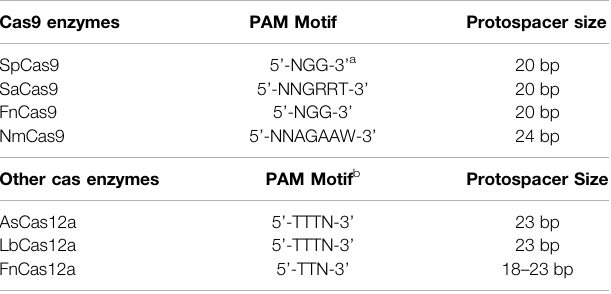
FIGURE1| OverviewofCas9(ordCas9)targetingmechanism .Cas9(or dCas9) recognizes and binds DNA using sgRNA. Brie fl y, Cas9:sgRNA complexes allow the PAM-interacting domain in Cas9 (or dCas9) to sample PAM motifs in the genome (Step 1). The Cas9:sgRNA complex also aligns the sgRNA for invasion of the target DNA. Following PAM sampling, recognition, and subsequent binding, the DNA duplex is locally unwound and